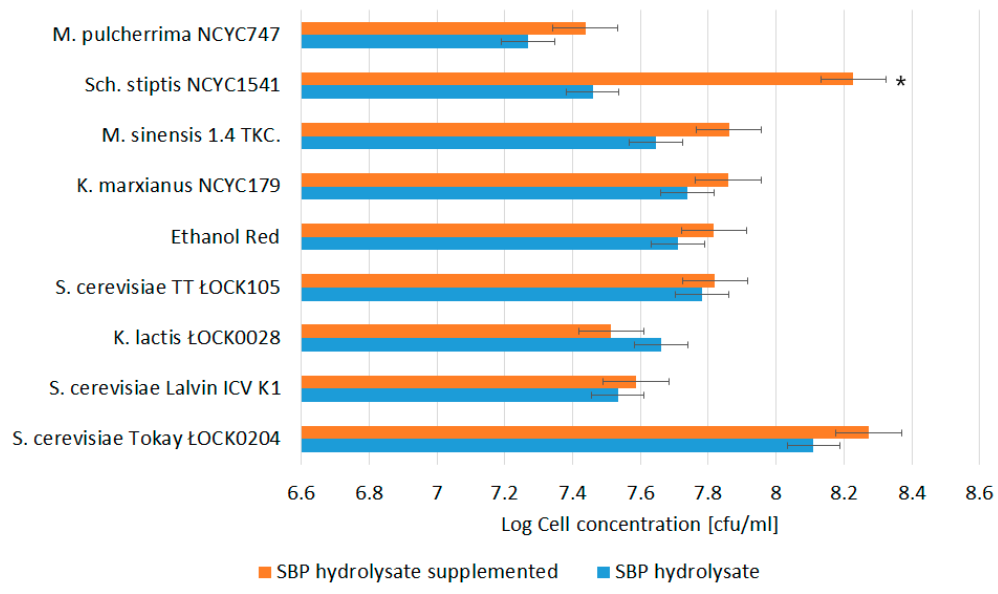
Figure 1. Yield of yeast cells cultivated on sugar beet pulp (SBP) hydrolysate. The data represent means from three replicates in one experiment. Error bars denote SD. * Results significantly different from unsupplemented control, ANOVA ( p < 0.05).